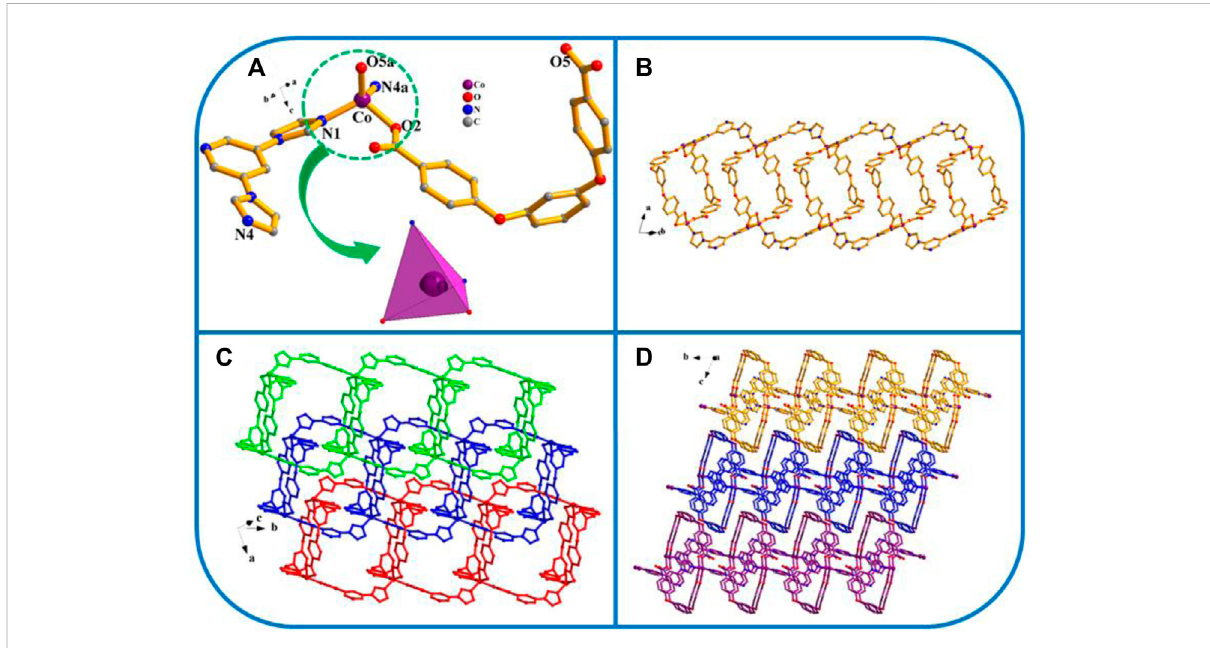
FIGURE 3 (A) CoordinationunitoftheCoioninYMUN3((hydrogenatomsareomittedforclarity),symmetrycodes:(i)- x +1,- y ,- z +1;(ii) x , y -1, z ;(iii) x , y +1, z .); (B) view of the single 1D structure of 3; (C) view of the mutually-interpenetrating 2D network through the identical 1D structures of 3; (D) view of the 3D framework through the 2D strati fi ed network with weak interactions occurring along the a